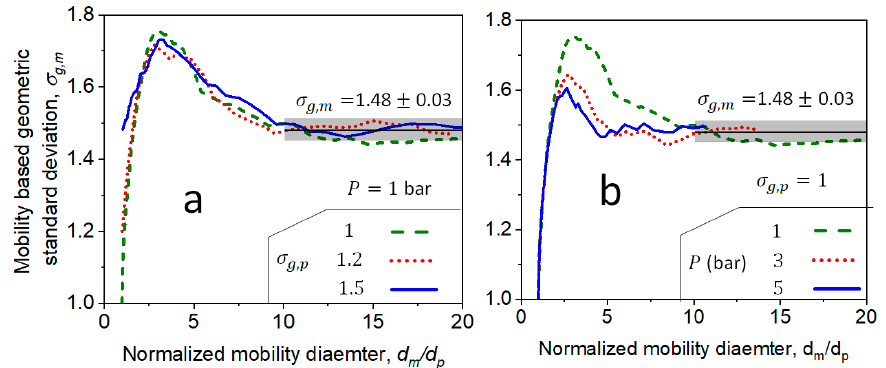
Figure 1. Evolution of geometric standard deviation of agglomerate mobility diameter, σ g , m , as a function of the normalized mobility diameter, d m / d p , during coagulation ( a ) at P = 1 bar for agglom- erates consisting of polydisperse primary particles with 1 ≤ σ g , p ≤ 1.5, and ( b ) for agglomerates of monodisperse primary particles coagulating at different pressures, 1 ≤ P ≤ 5